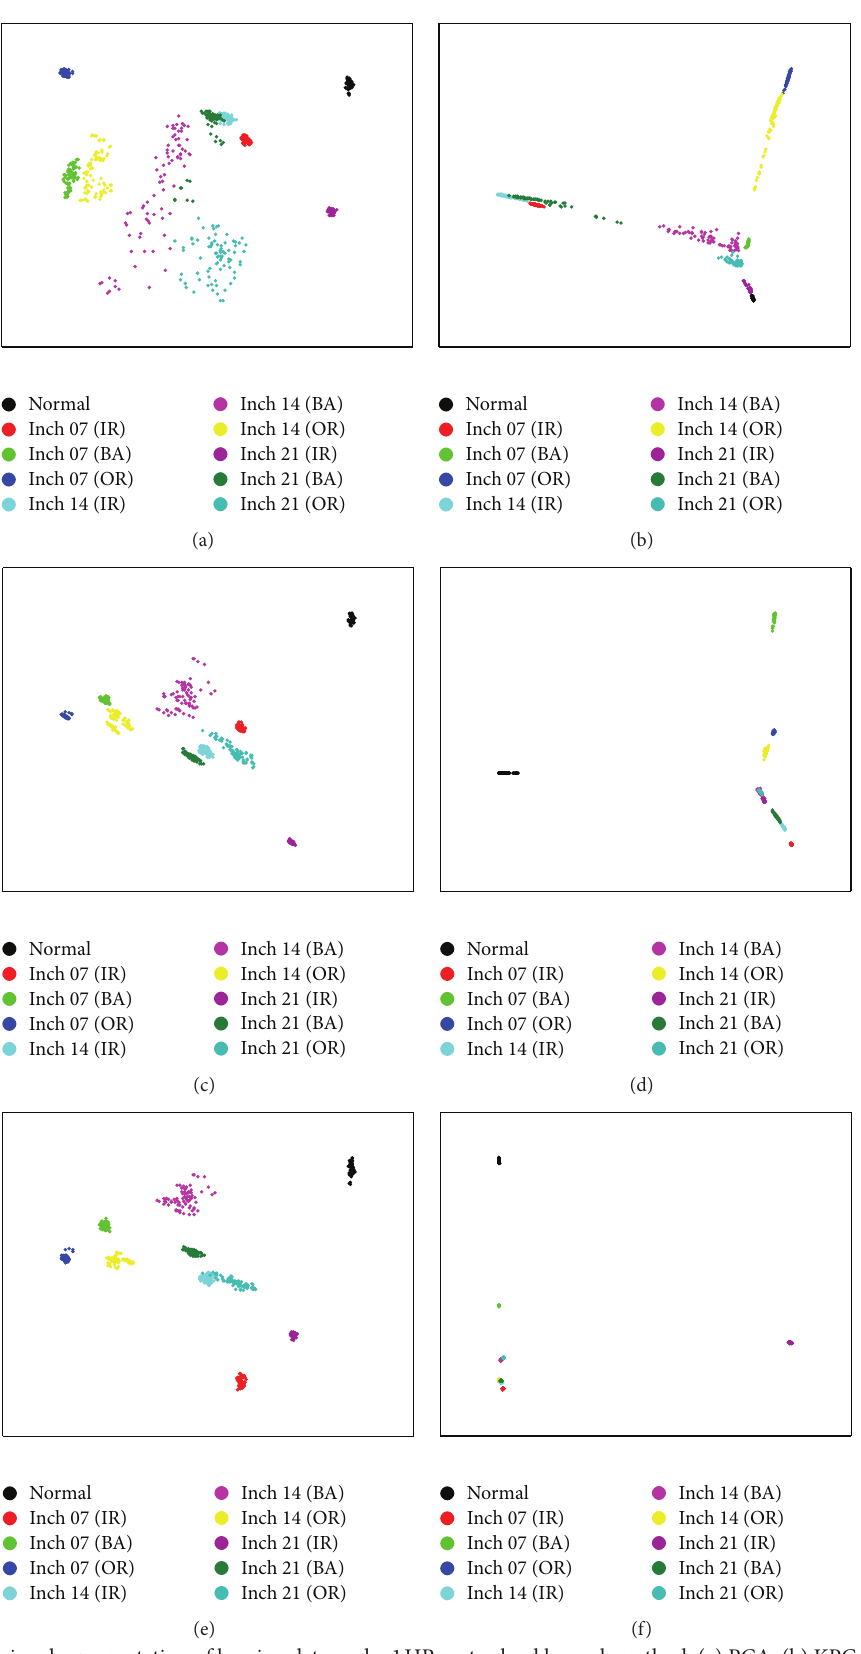
Figure 2: Two-dimensional representation of bearing data under 1HP motor load by each method: (a) PCA; (b) KPCA; (c) LDA; (d) KDA; (e) TR-LDA; (f)